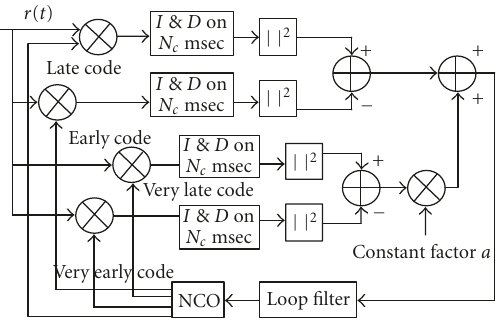
Figure 5: Block diagram for HRC tracking loop.